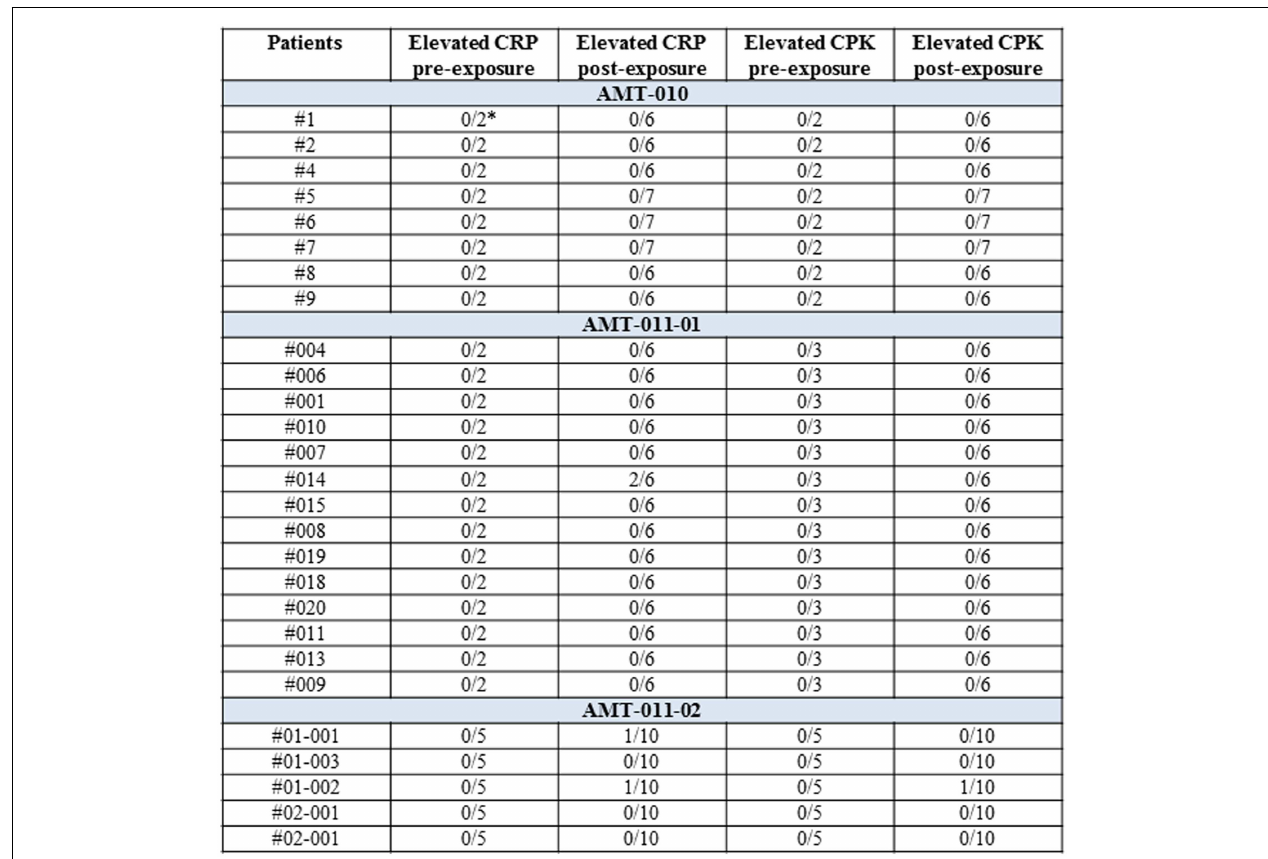
FIGURE 7 |A per-patient summary of CRP and CPK values pre- and post-exposure to alipogene tiparvovec . Scheduled visits pre-treatment and post-treatment have been included.The post-treatment visits were at day 1 and weeks 1, 2, 4, 8, and 12 for studies CT-AMT-010 and CT-AMT-011-01. Weeks 14, 26, 39, and 52 were added for study CT-AMT-011-02. In the study